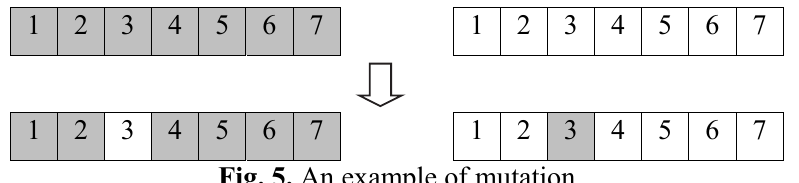
Fig. 5. An example of